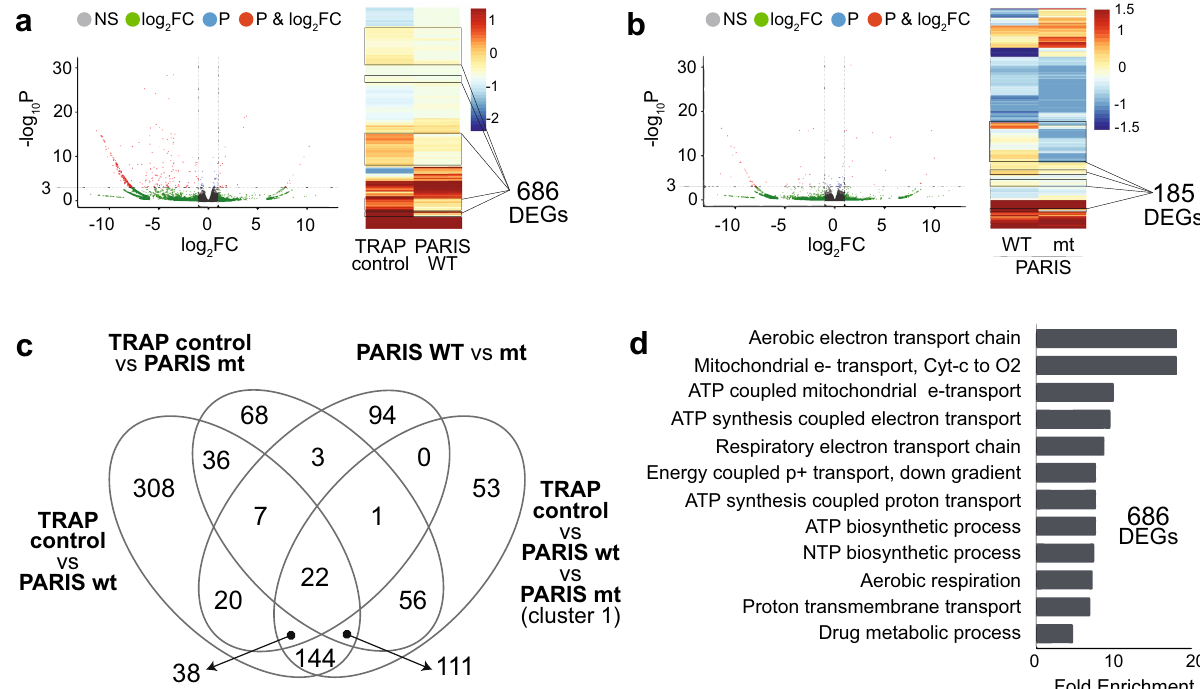
Figure 2 . Two pairwise comparisons shed light on PARIS-driven global expression changes in fly DA neurons. ( a - b ) Only “TRAP control versus PARIS wild type” and “PARIS C571A mutant versus PARIS wild type” pairwise comparisons with a special focus on transcriptional suppression generated biologically meaningful outcome. ( c ) A Venn diagram 19 showing only for these two comparisons mentioned here majority of the DEGs that are downregulated are comparison-specific, not shared as in the rest of the comparisons. ( d ) Functional enrichment results of 686 DEGs identified as downregulated from the “TRAP control versus PARIS wild type” comparison, implying mitochondrial dysfunction underlying PARIS